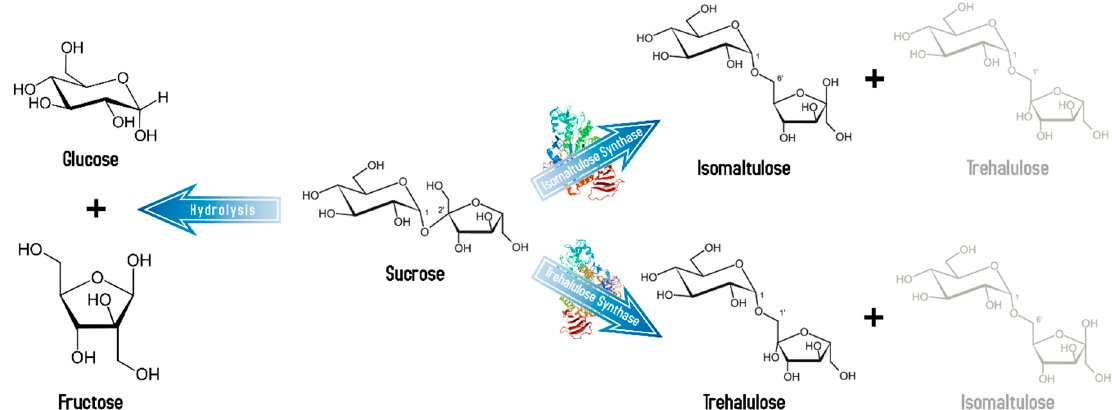
Figure 3. Isomaltulose and trehalulose production. Synthesis of the non-starch slowly digestible sucrose isomers by the isomaltulose synthase (PDB ID: 1M53) and trehalulose synthase (PDB ID: 1ZJA). Minor products of the reaction are represented by faint text. Blood glucose and insulin levels in humans after oral administration of these carbohydrates rise slower and reach lower maxima than after sucrose administration [60]. After hydrolysis of these disaccharides by the human small intestinal mucosal enzymes, fructose and glucose are metabolized as typical for these monosaccharides.